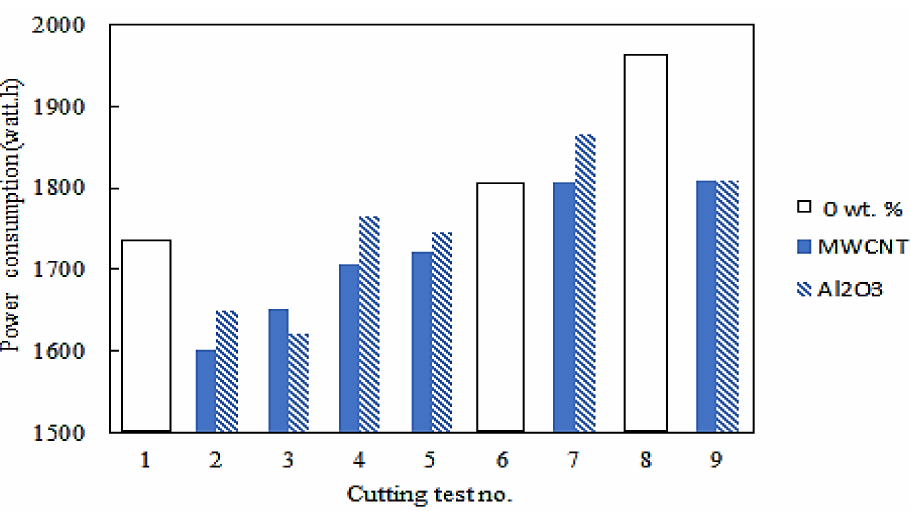
Figure 2. Average surface roughness results.